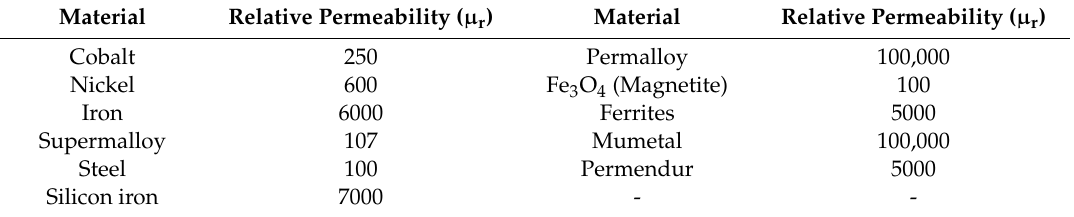
Table 8. Relative permeability of conventional ferromagnetic materials.